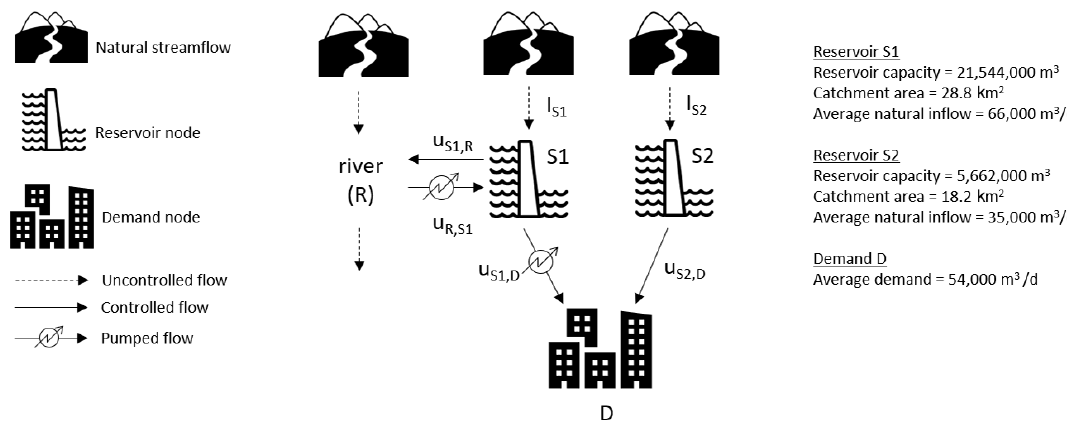
Figure 2. A schematic of the reservoir system investigated in this study to test the real-time optimization systems. Reservoir inflows from natural catchments are denoted by I, S1 and S2 are the two reservoir nodes, u denotes controlled inflows/releases, R is the river from/to which reservoir S1 can abstract and release, and D is a demand